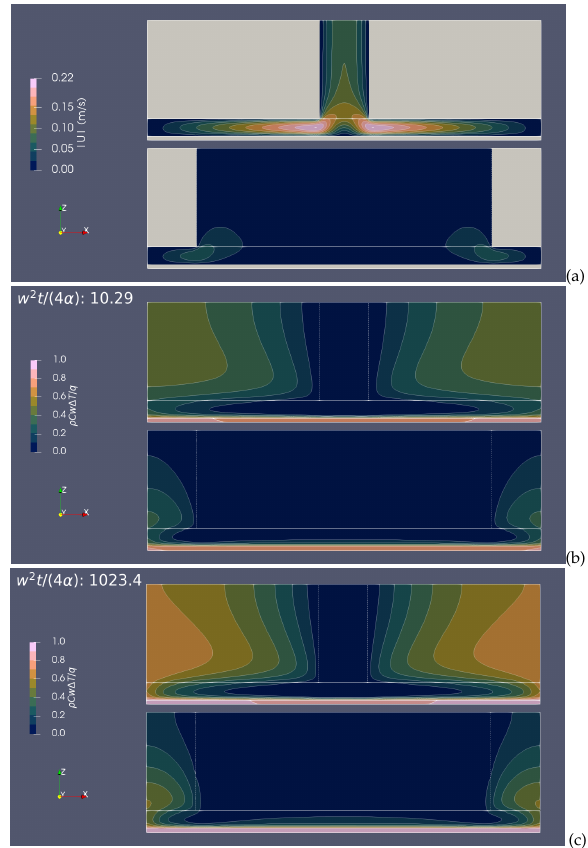
Figure 9. Velocity magnitude and printhead temperature rise on symmetry plane. ( a ) steady flow Figure12. Velocitymagnitudeandprintheadtemperatureriseonsymmetryplane. (a)steadyflow velocitymagnitude;(b)temperaturerise, w 2 t / ( 4 α ) = 10.29;(c)temperaturerise, w 2 t / ( 4 α ) = 1023.4. velocity magnitude; ( b ) temperature rise, w 2 t / ( 4 α ) = 10.29; ( c ) temperature rise, w 2 t / ( 4 α ) = much longer to reach a steady state than the one-dimensional result; similar behaviour is 307 also seen with the two other models with progressively less solids. As expected, the model 308 without solids matches the one-dimensional analytical result: the simulation model in that 309 case consists only of heat applied to the bottom of an ink layer, as per the theory. The extra 310 solid components add not only pathways for heat to leak through instead of the ink, but 311 also cause the flow to undergo deceleration and changes in direction which enhance the 312 heat transfer, thus lowering the temperature at the bottom of the silicon.